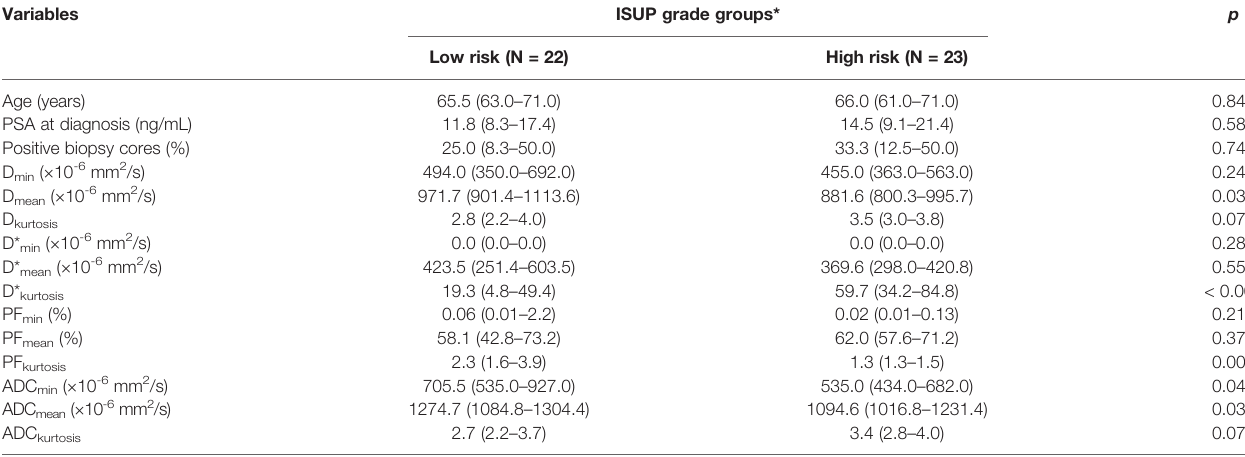
TABLE 3 | Associations of clinical characteristics and IVIM/ADC parameters obtained before radical prostatectomy with fi nal risk groups of 45 prostate cancer patients. Variables